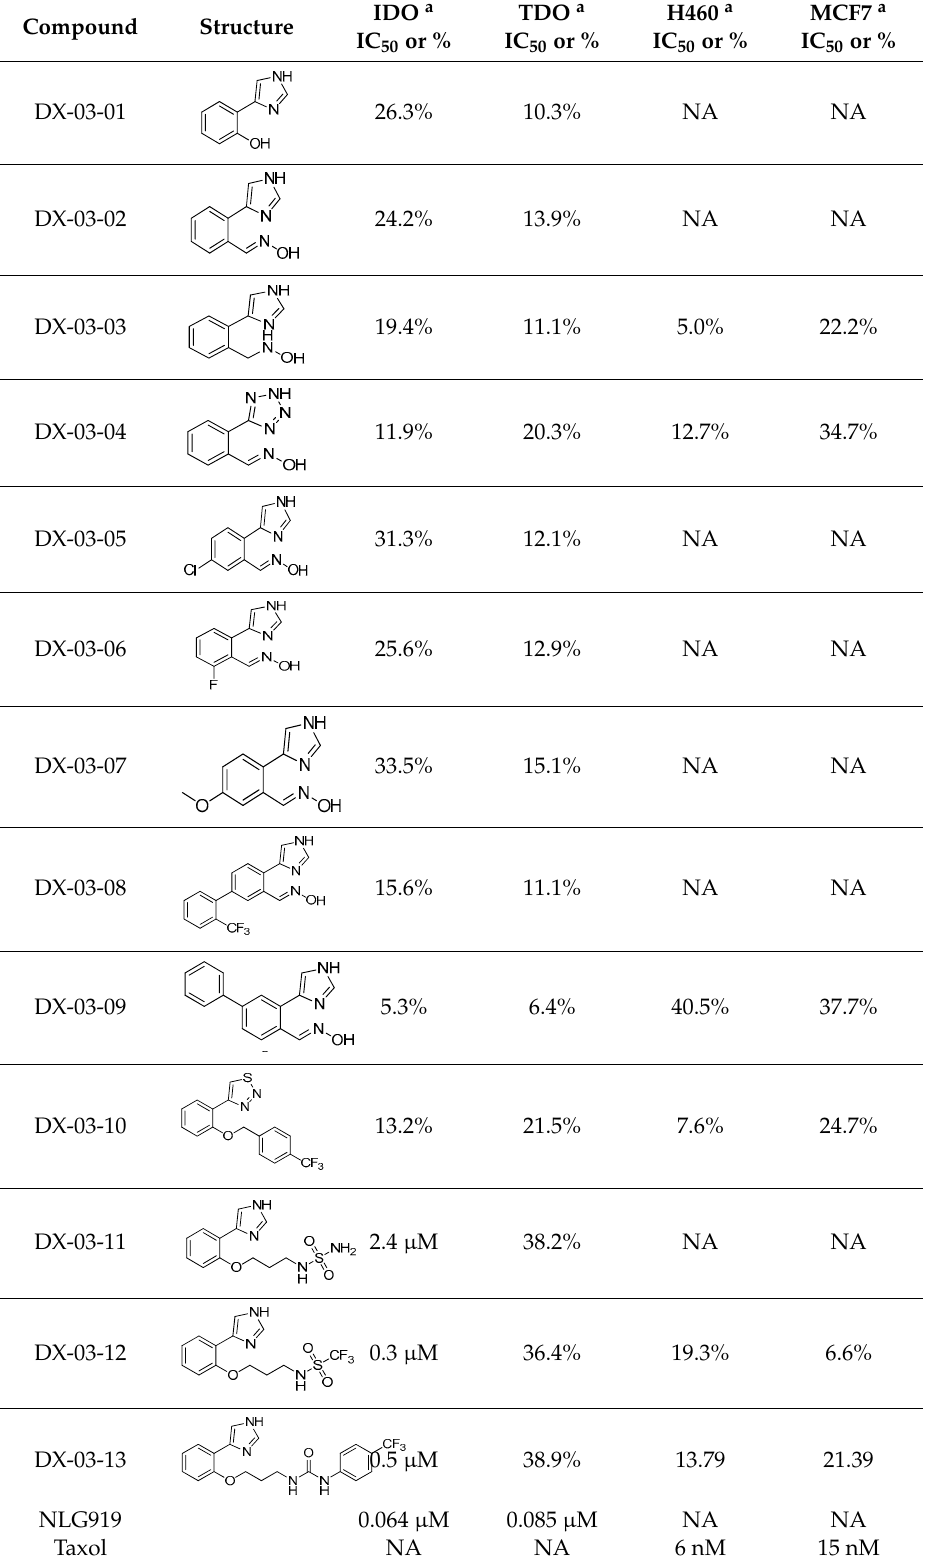
Table 3. In vitro IDO1 / TDO inhibitory activities and cell cytotoxicity of series 3. Table 3. In vitro IDO1/TDO inhibitory activities and cell cytotoxicity of series 3. Table 3. In vitro IDO1/TDO inhibitory activities and cell cytotoxicity of series 3. Table 3. In vitro IDO1/TDO inhibitory activities and cell cytotoxicity of series 3. Table 3. In vitro IDO1/TDO inhibitory activities and cell cytotoxicity of series 3. Compound Compound Table 3. In vitro IDO1/TDO inhibitory activities and cell cytotoxicity of series 3. Compound Table 3. In vitro IDO1/TDO inhibitory activities and cell cytotoxicity of series 3. Compound Table 3. In vitro IDO1/TDO inhibitory activities and cell cytotoxicity of series 3. Compound Structure Table 3. In vitro IDO1/TDO inhibitory activities and cell cytotoxicity of series 3. Table 3. In vitro IDO1/TDO inhibitory activities and cell cytotoxicity of series 3. Compound Structure Table 3. In vitro IDO1/TDO inhibitory activities and cell cytotoxicity of series 3. Compound Compound Table 3. In vitro IDO1/TDO inhibitory activities and cell cytotoxicity of series 3. Compound Compound